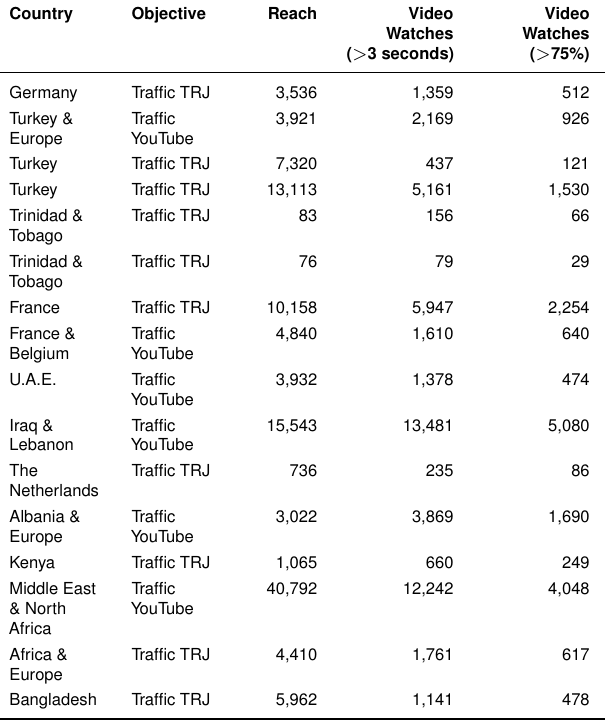
Table 4. Overview of